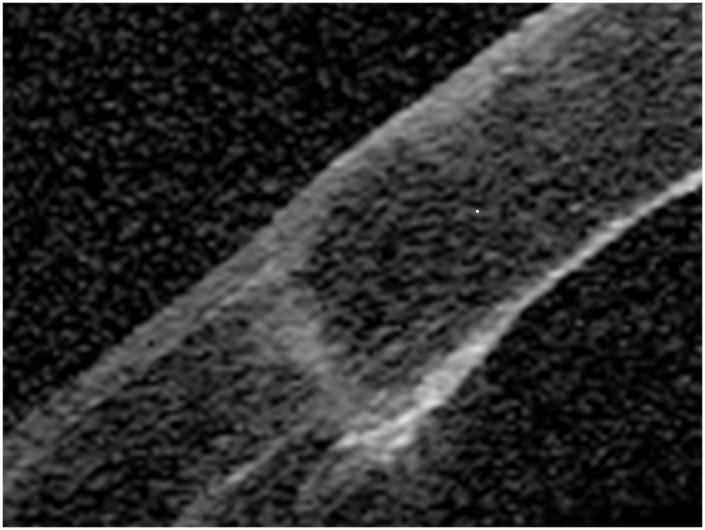
Anterior segment optical coherence tomography image after femtosecond laser assisted penetrating keratoplasty using a straight cut with angles of 90°.